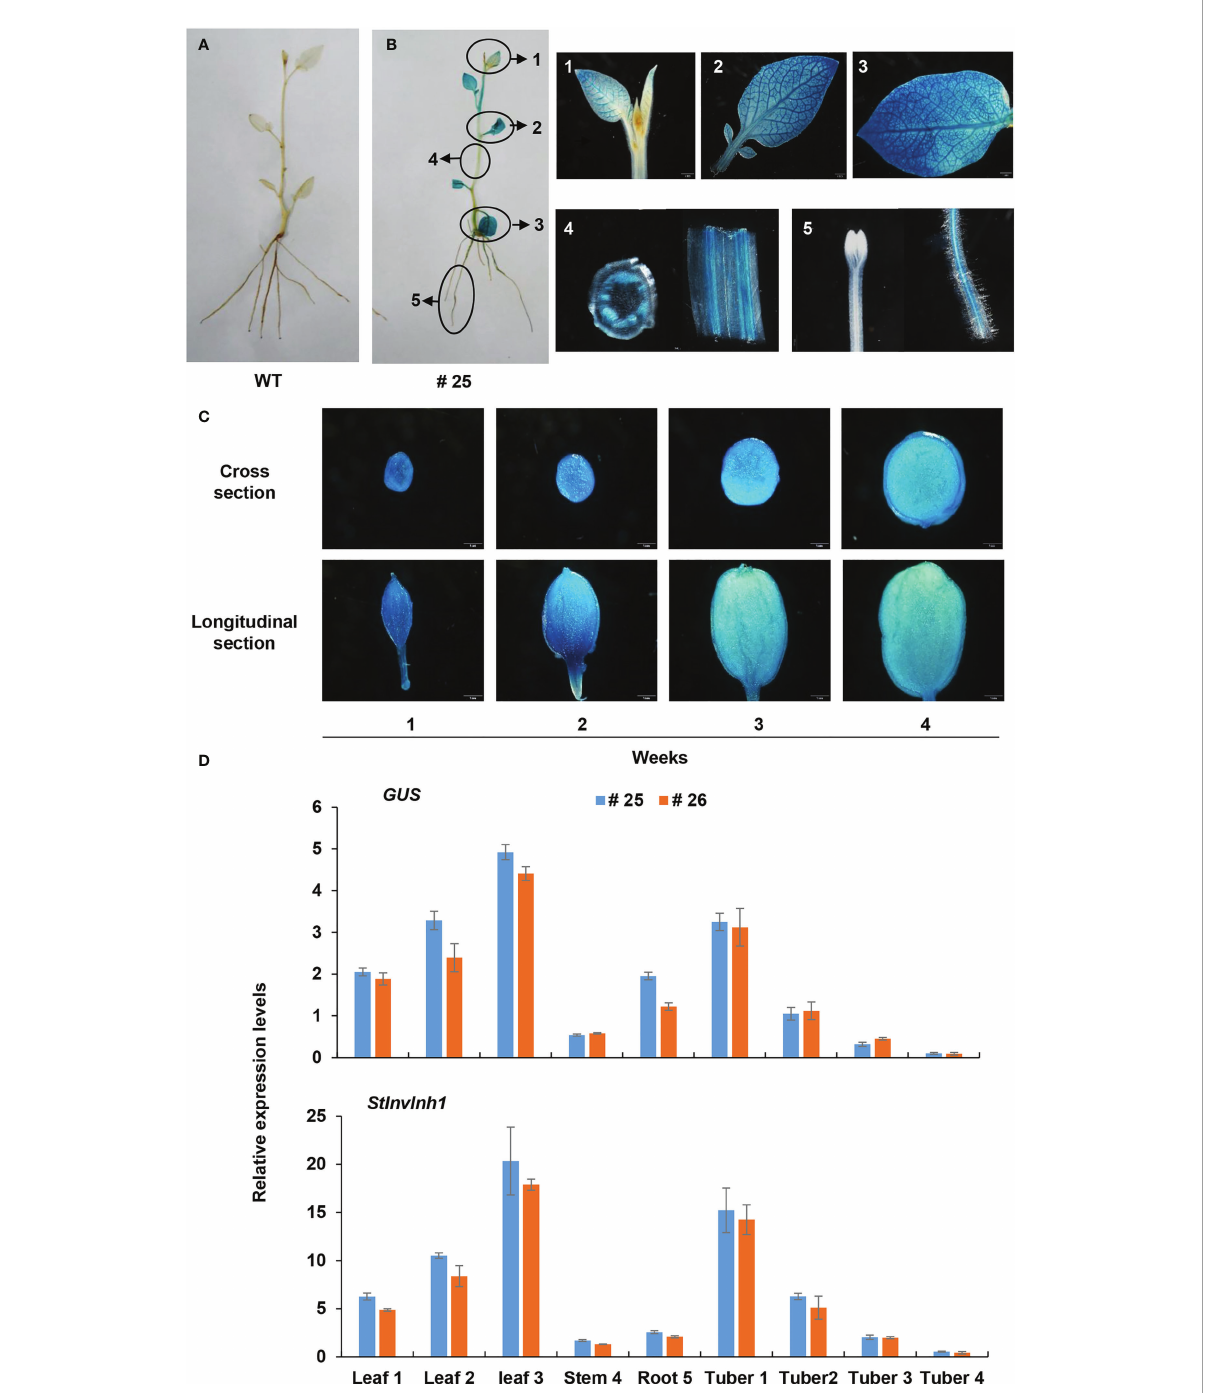
FIGURE 3 Expression pattern of GUS under the control of the StInvInh1 promoter. (A) GUS staining in plantlets of WT; (B) GUS staining in plantlets of a representative transgenic line (#25); (C) GUS staining in micro-tubers of a representative transgenic line (#25); (D) The relative expression levels of GUS and StInvInh1 in two representative transgenic line (#25 and #26). The 4-week-old plantlets and micro-tubers in vitro were subjected to the GUS staining and GUS expression. Leaves, stems, roots and developing micro-tubers were observed. Each repeat sample contains at least 6 plantlets or micro-tubers. Each sample was distributed into two groups. One was used for histochemical GUS staining; the other was frozen in liquid nitrogen and stored at -80°C for GUS expression analysis. The expression level of potato ef1 a (AB061236) was set as 100 and used for normalization. Each data point is mean value of triplicate